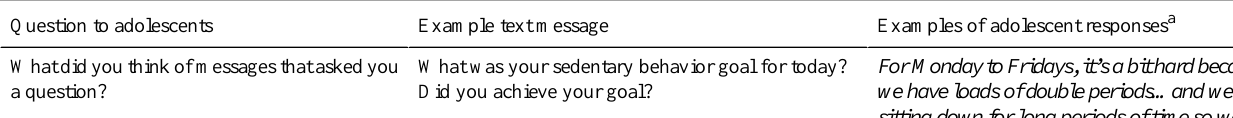
Table 2. Text message examples used to represent the style of text messages sent in the high intensity maintenance period.